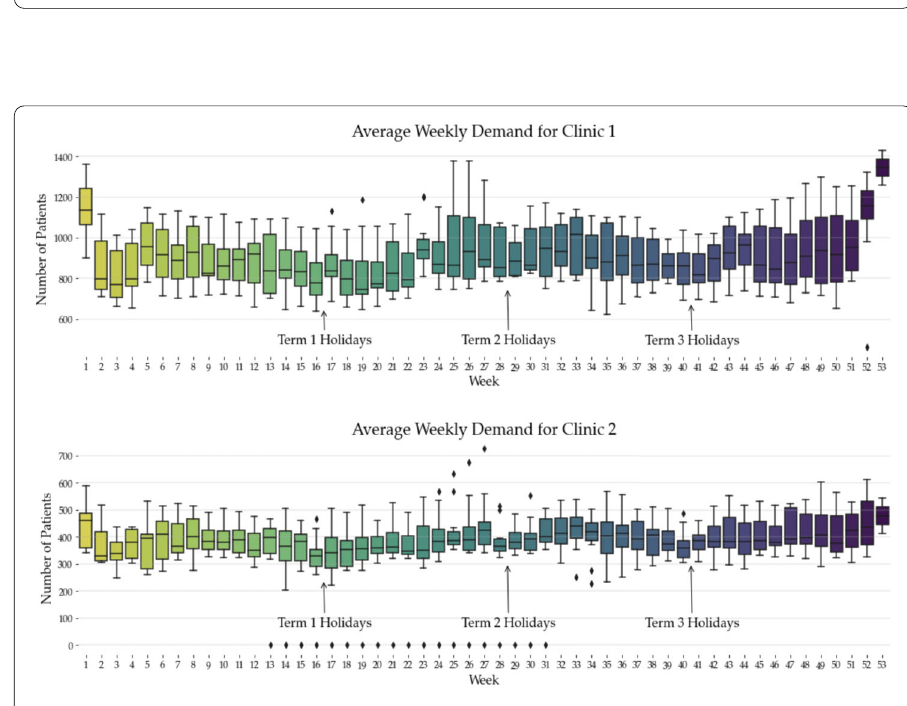
Figure 3 Average patient demand across both UCCs for all years by week number